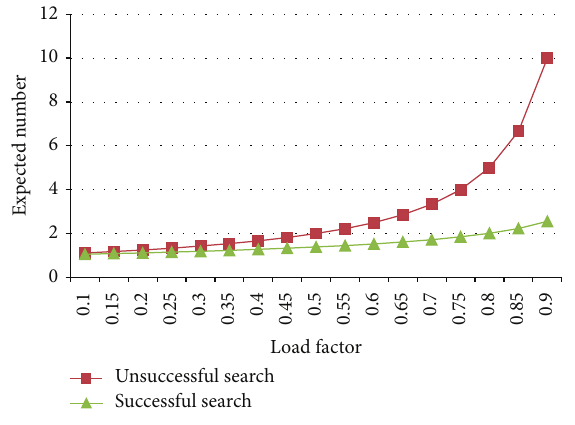
Figure 5: Expected number of probes.